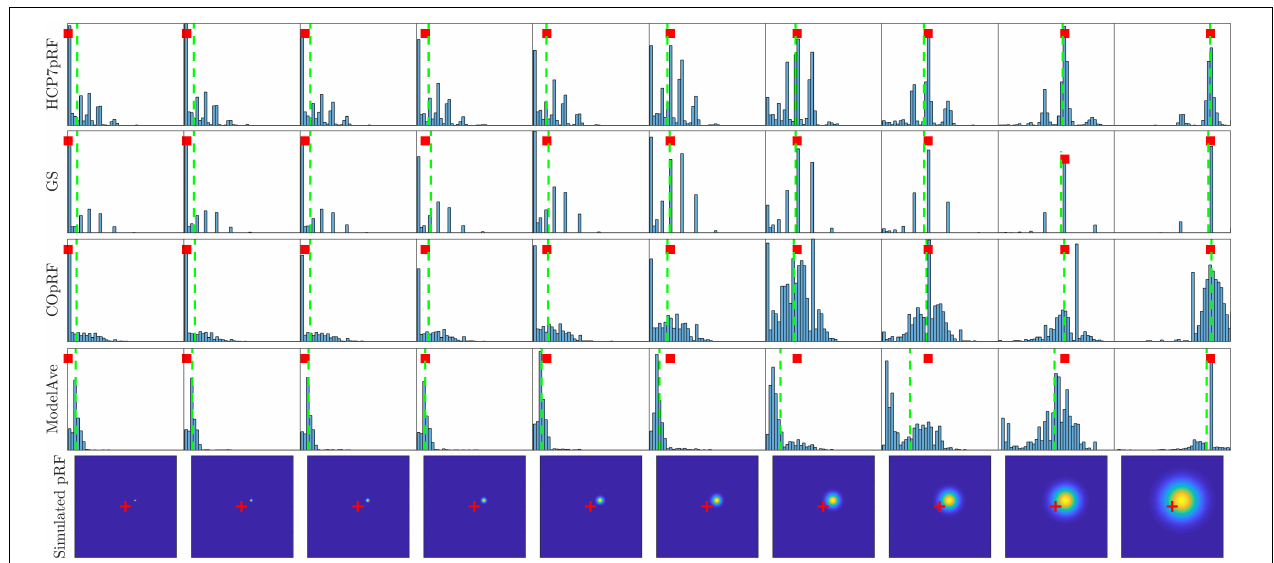
FIGURE 8 | Histograms of the estimated pRF size for HCP7pRF, GS, COpRF and ModelAve. The bottom row shows the simulated pRF (the fovea is marked in red). In all other plots, the red square denotes the pRF size value used to simulate the data (i.e., the targeted value to be estimated). The vertical green lines denote the median of the distribution of the estimated pRF